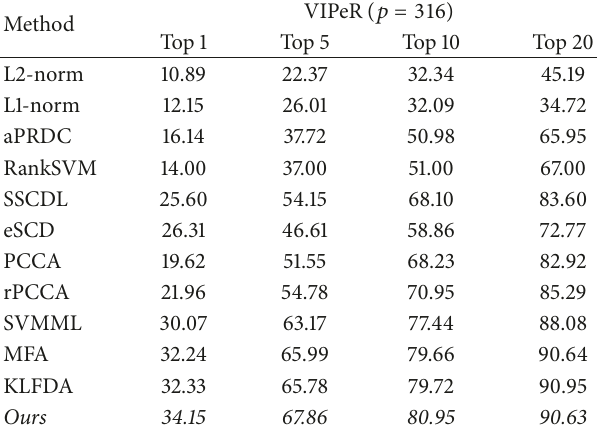
Table 6: Comparison of some other state-of-the-art results reported with VIPeR database. The cumulative matching scores (%) at ranks 1, 5, 10, and 20 are listed.